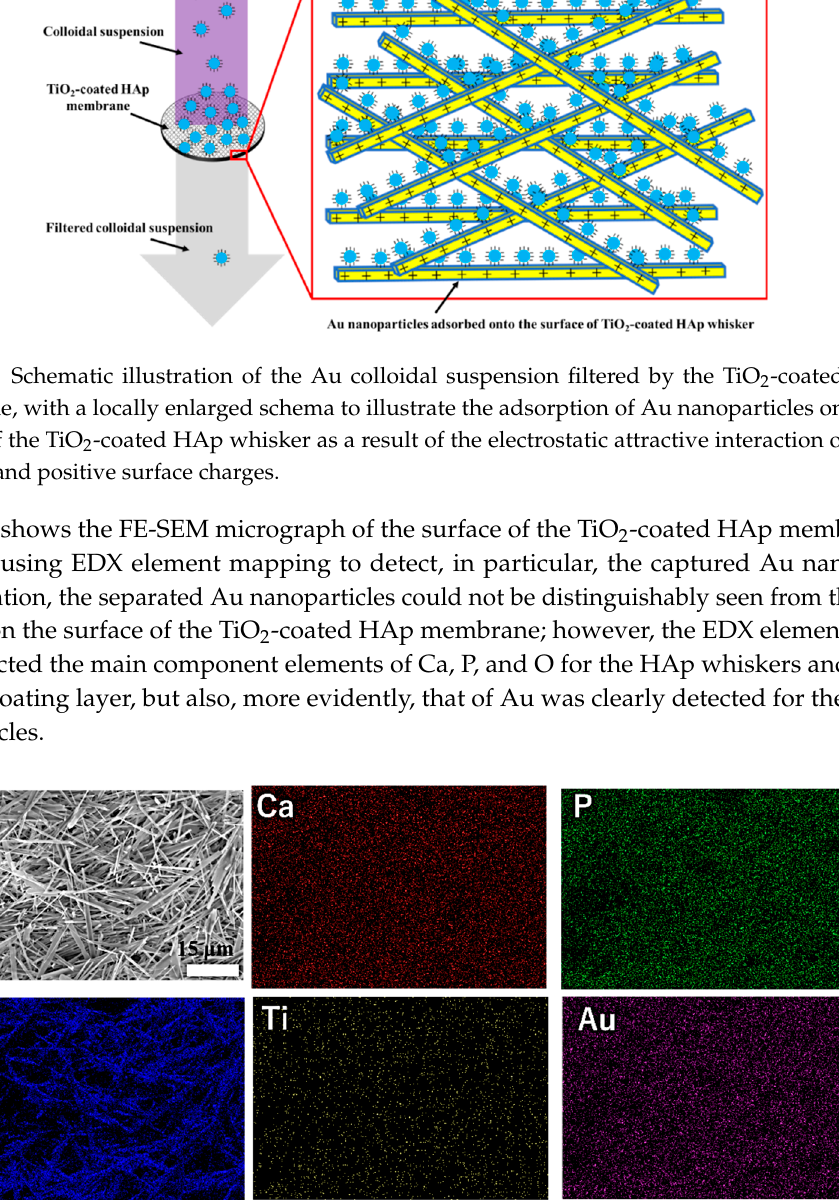
Figure 6. ( a ) UV-vis spectra of the Au colloidal suspensions before and after the filtration by using the membrane fabricated by the HAp and TiO 2 -coated HAp whiskers; ( b ) photographs showing the color difference of these Au colloidal suspensions.